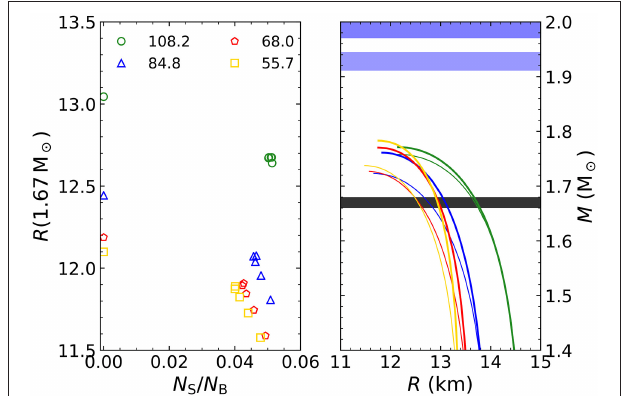
FIGURE 5 | (Left) Radius of a 1.67 M NS as a function of the total strange ⊙ baryonic fraction N S / N B at the maximum mass for four TM1 ωρ models with four different values of the slope L : 55.7, 68.0, 84.8, and 108.2 MeV. (Right) M-R curves obtained with the models with the different values of L for U 6 30 MeV (thick lines) and 10 MeV (thin lines). The line color indicates = + − the value of the L as in the left panel. The blue upper bands show the constraints set by the pulsars PSR J1614 2230 and PSR J0348 − +